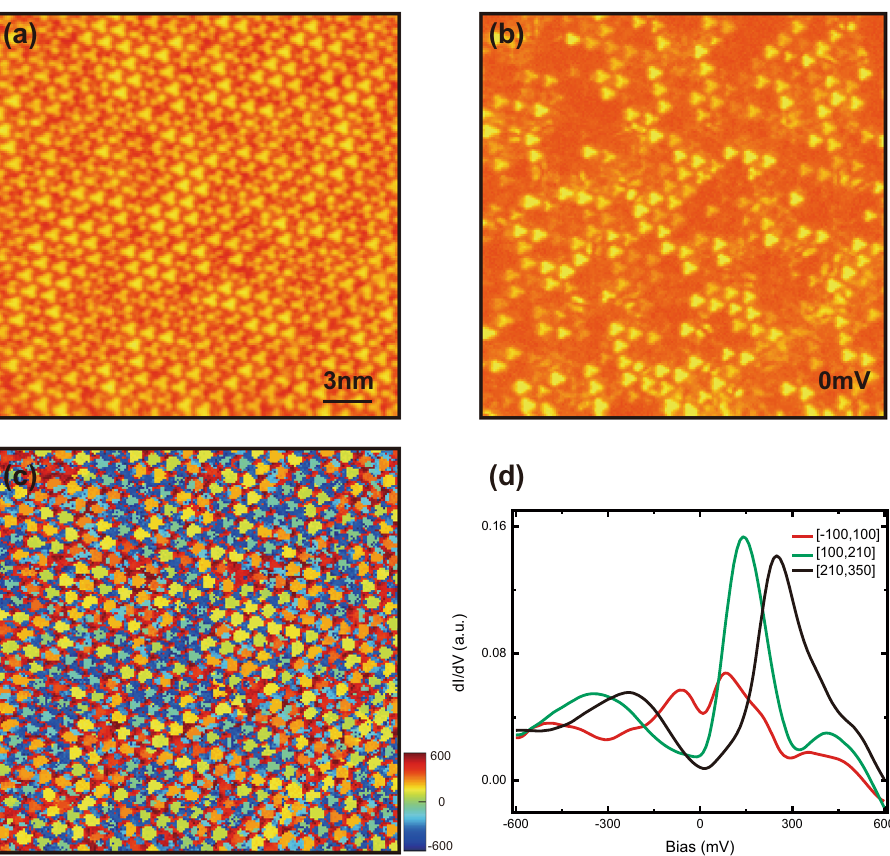
Fig. 5 Disorder at a x = 0.08 sample. a A 30 × 30 nm 2 topography for a x = 0.08 sample ( V b = − 600 mV, I s = 500 pA). b The dI / dV map at the Fermi level. The high intensity area corresponds to the undoped SDs in topography. c The maximum peak map of the dI / dV spectra in the same area. d The averaged dI / dV spectra of different range in the maximum peak